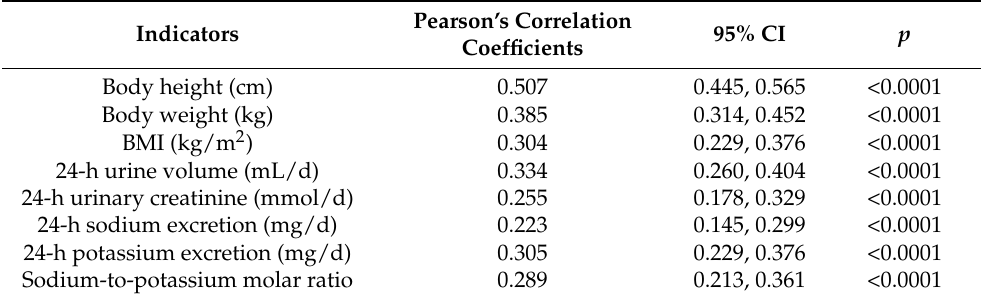
Table 2. Correlation of indicators between children and the average of their two adult family